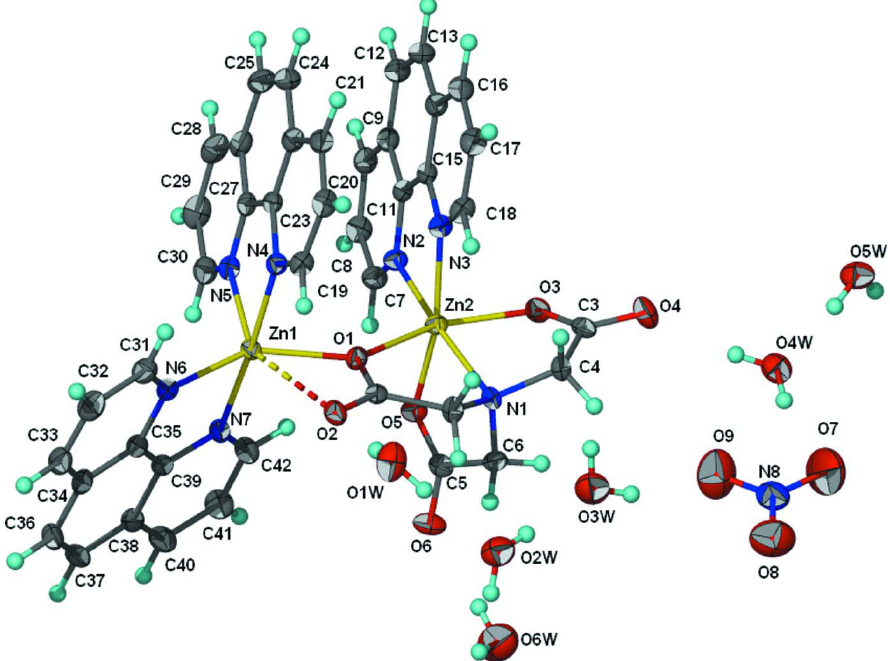
Figure 1 70% Probability displacement ellipsoid plot (Barbour, 2001) of [Zn are drawn as spheres of arbitrary radii. The Zn···O interaction of 2.401 (2) Å is shown as a dashed